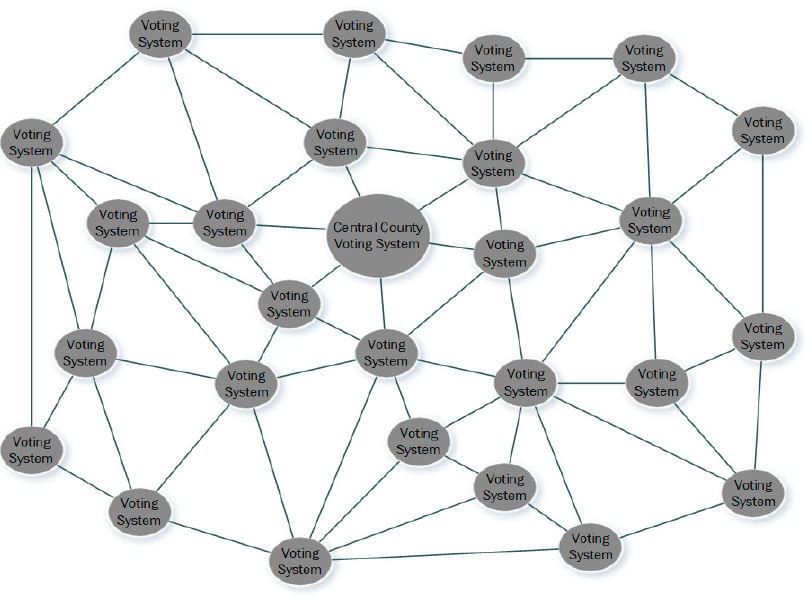
Figure 4. Distributed online e-voting within a county as well as in-person voting working simulta- neously.